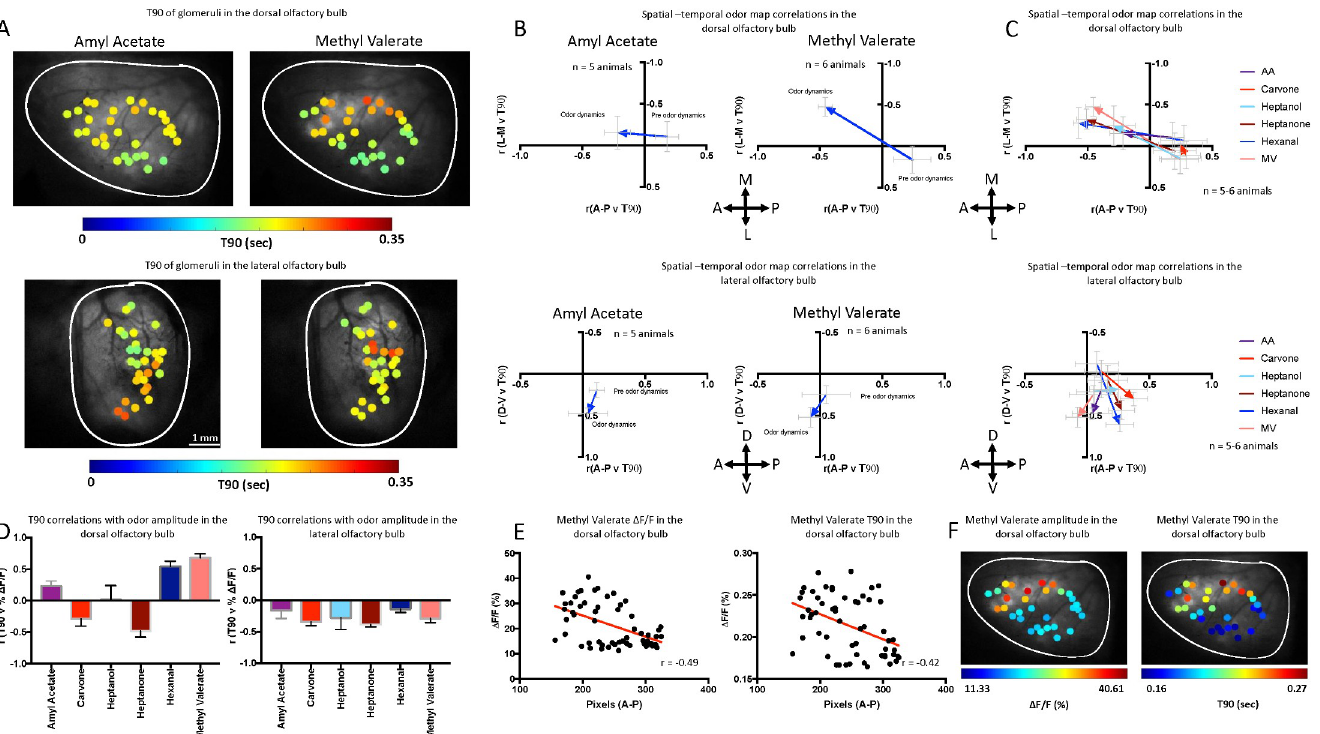
Fig 3. Temporal dynamics of the dOB and lOB. (A) Color-scaled T90 of responses by ROIs for AA and MV. Top: the dorsal region of the OB. Bottom: the lateral region of the OB (1 animal). (B) Comparison of spatiotemporal odor dynamics, i.e., correlation between T90s of glomeruli and their location along each dimension across the dOB of AA ( n = 5 mice) and MV ( n = 6 mice) from pre-odor (breathing response to clean air) to odor onset (1st odor response peak). Arrow represents the direction from pre-odor to odor on. Top: the dorsal region of the OB, data are represented in both the A-P directions and the M-L as shown in panel A. Bottom: the lateral region of the OB, data are represented in both the A-P directions and the D-V as shown in panel A. Error bars are SEM. (C) Spatiotemporal odor map dynamics for all odors. Top: the dorsal region of the OB. Bottom: the lateral region of the OB (AA, heptanol, and hexanal 5 animals; all others 6 animals). (D) T90 correlations with odor amplitude ( Δ F/F). Left: the dorsal region of the OB. Right: the lateral region of the OB. Error bars are SEM (AA, heptanol, and hexanal 5 animals; all others 6 animals). (E) Left: correlation of glomerular response amplitudes to MV sorted from anterior to posterior in the dOB (r 2 = 0.24, slope = − 0.08 ± 0.02, 1 animal, 57 glomeruli). Right: correlation of glomerular T90 responses to MV sorted from anterior to posterior in the dOB (r 2 = 0.18, slope = − 0.0002 ± 0.0009, 1 animal, 57 glomeruli). (F) Left: amplitude of glomeruli represented on a color scale. Red indicates high responses and blue low. Right: T90 of glomeruli represented on a color scale. Red indicates the slowest responses and blue the fastest (1 animal [same as panel E], 57 glomeruli). Underlying data for this figure can be found in S1 Data. A-P, anterio-posterior; AA, amyl acetate; D-V, dorso-ventral; dOB, dorsal olfactory bulb; lOB, lateral olfactory bulb; M-L, medio- lateral; MV, methyl valerate; OB, olfactory bulb; ROI, region of interest.